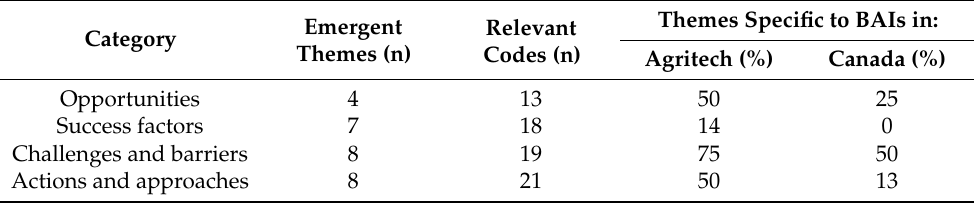
Table 1. Summary of emergent theme numbers and specificity to BAIs in agritech and